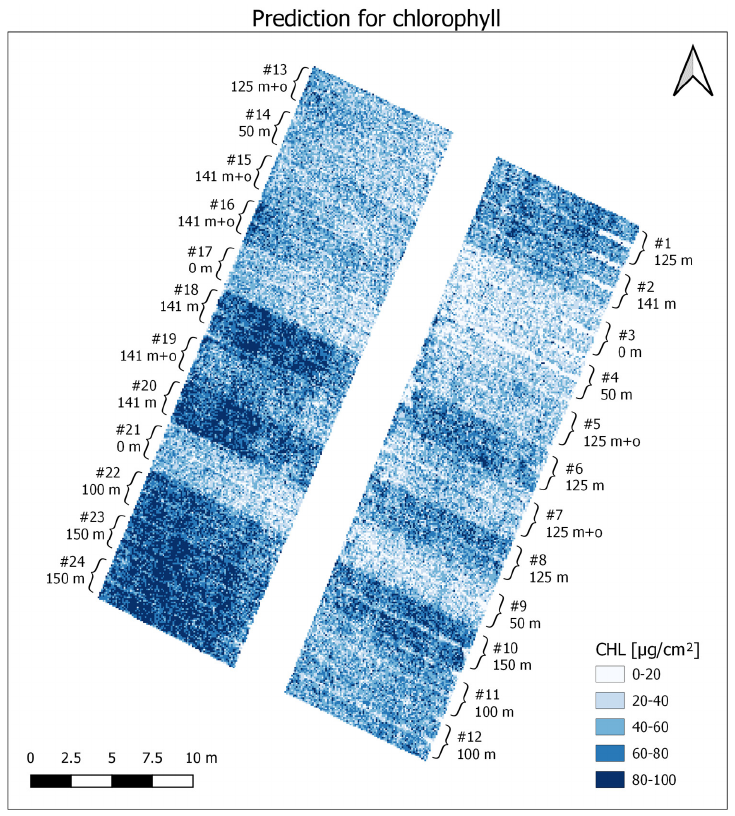
Figure 10. Spatial prediction for CHL based on PLSR model.